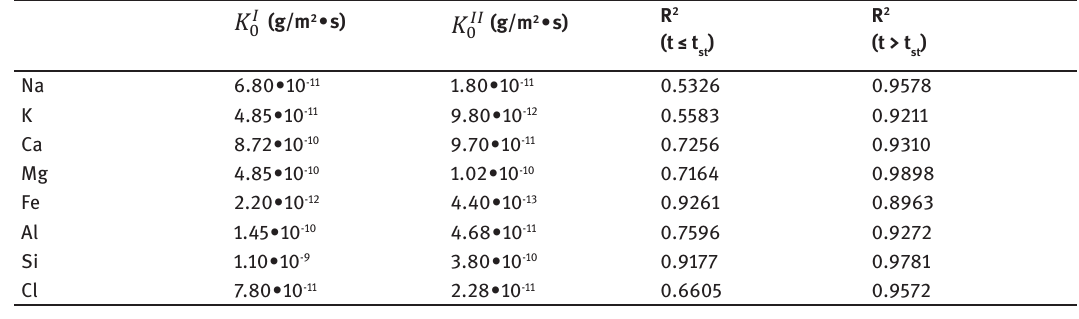
Table 2: Model parameters for individual released ions and fit to experimental data. (cid:1837) (cid:2868)(cid:3010) (g/m 2 ∙s)